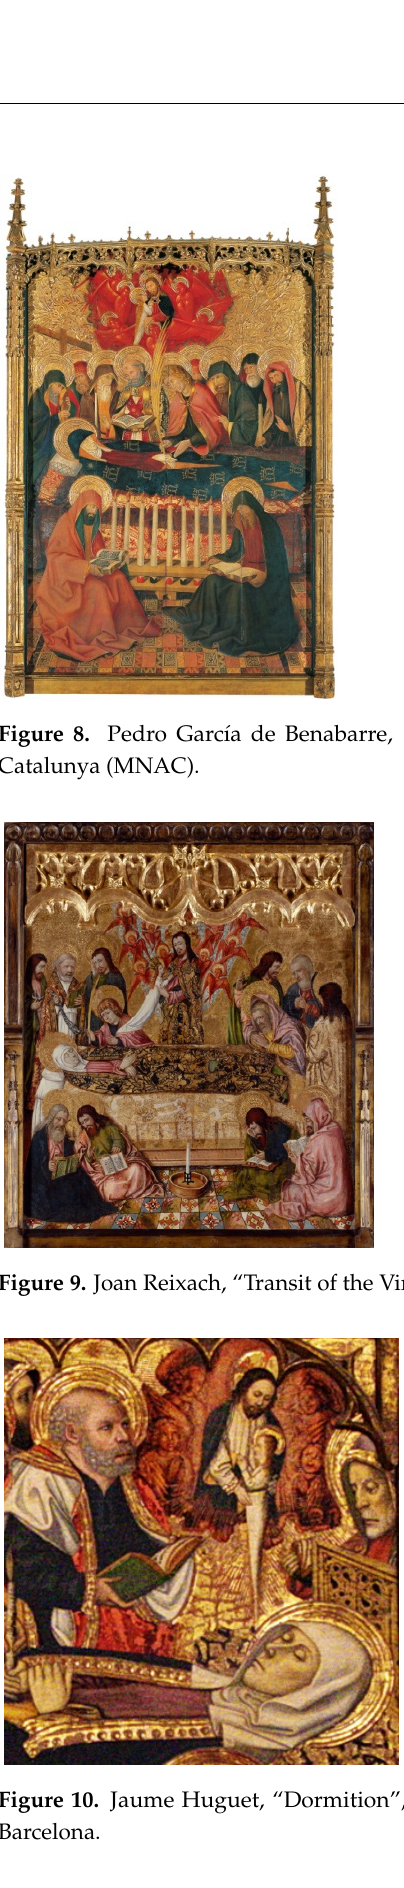
Figure 10. Jaume Huguet, “Dormition”, Altarpiece of the Constable , 1462, Chapel of Saint Agatha, Barcelona.